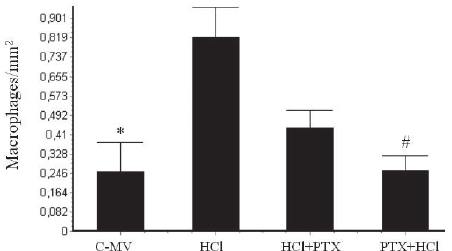
Figure 5 - Effects of PTX on morphometric counts of macrophages per alveolar area in the lung tissue in the groups C-MV, HCl, HCl+PTX and PTX+HCl . * p <0.05 versus the HCl and HCl+PTX groups, and # p <0.05 versus the HCl and the HCl+PTX groups. Values are presented as mean ±